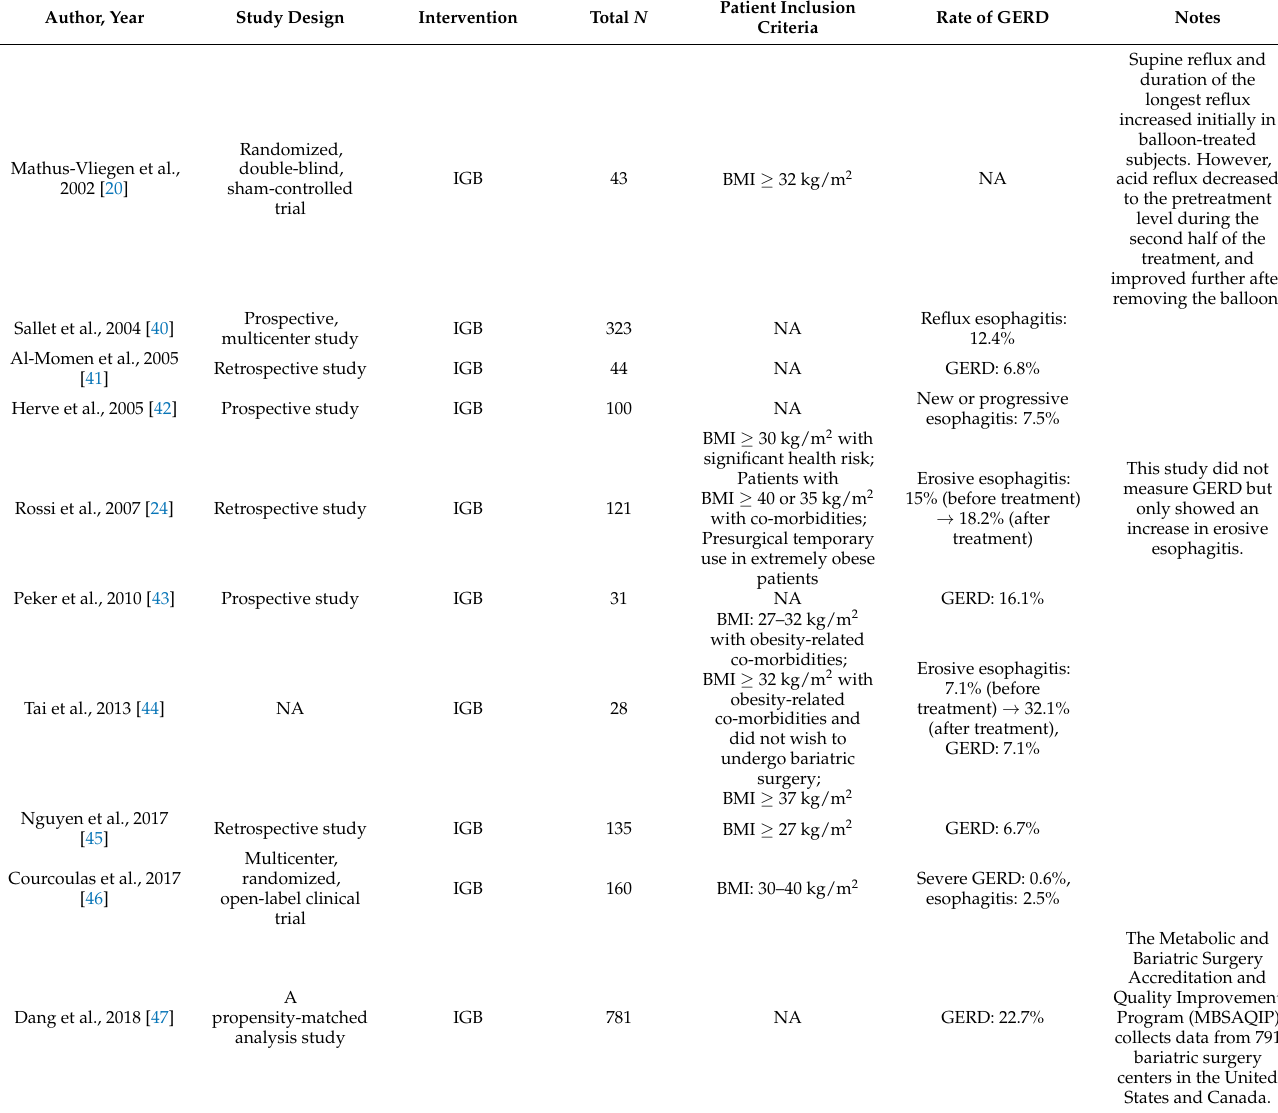
Table 1. Clinical outcomes of endoscopic bariatric and metabolic therapies for gastroesophageal reflux